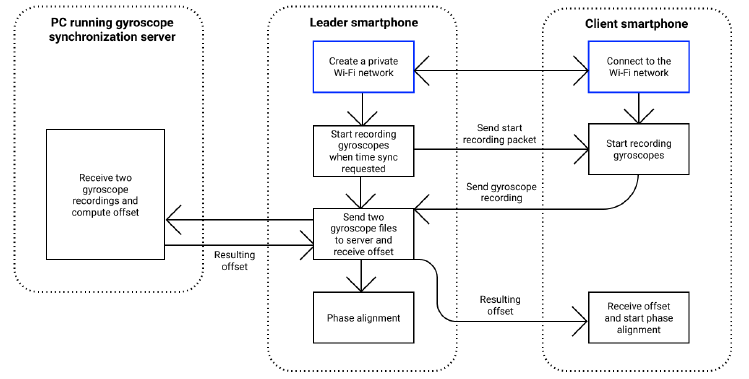
Figure 11. Modified libsoftwaresync pipeline.